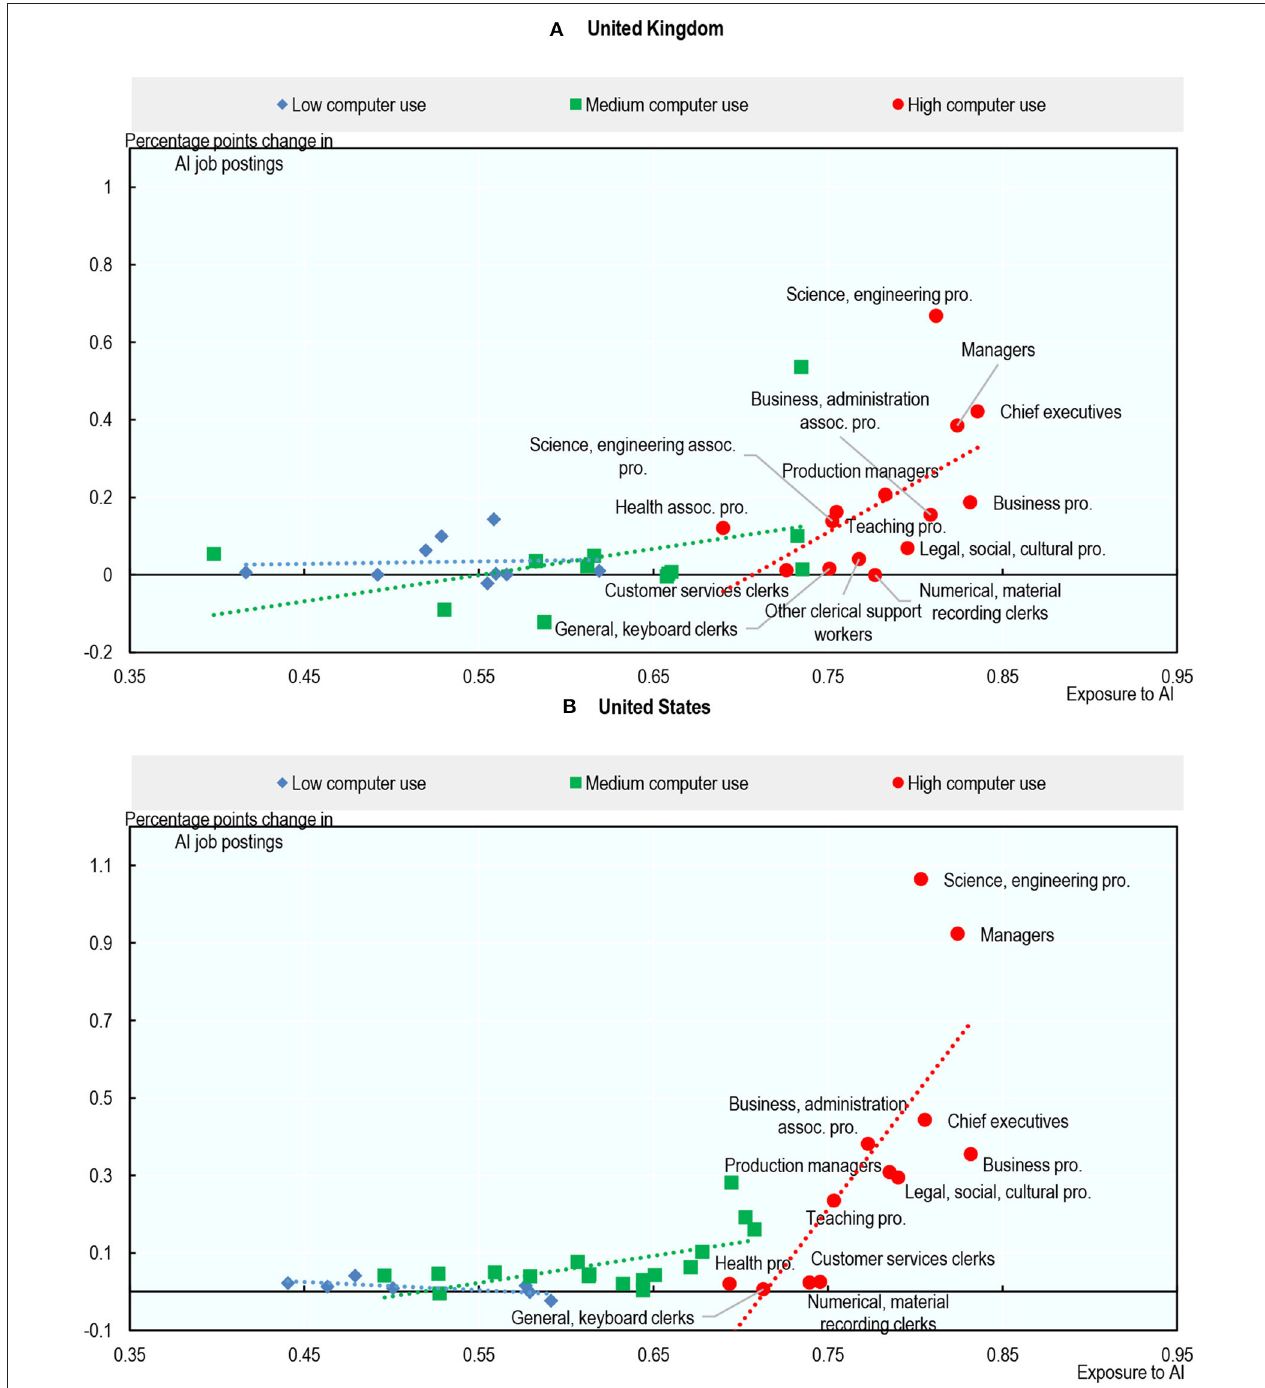
FIGURE 15 | High computer use occupations with higher exposure to AI saw a higher increase in their share of job postings that require AI skills. Percentage point change in the share of job postings that require AI skills (2012–2019) and exposure to AI (2012). The share of job postings that require AI skills in an occupation is taken as a share of the total number of job postings in that occupation. Occupation-country cells are classified into low, medium or high computer use by tercile of computer use applied across the full sample of occupation-country cells. Source: Author’ calculations using data from Burning Glass Technologies, PIAAC, and Felten et al. (2019). (A) United Kingdom and (B) United